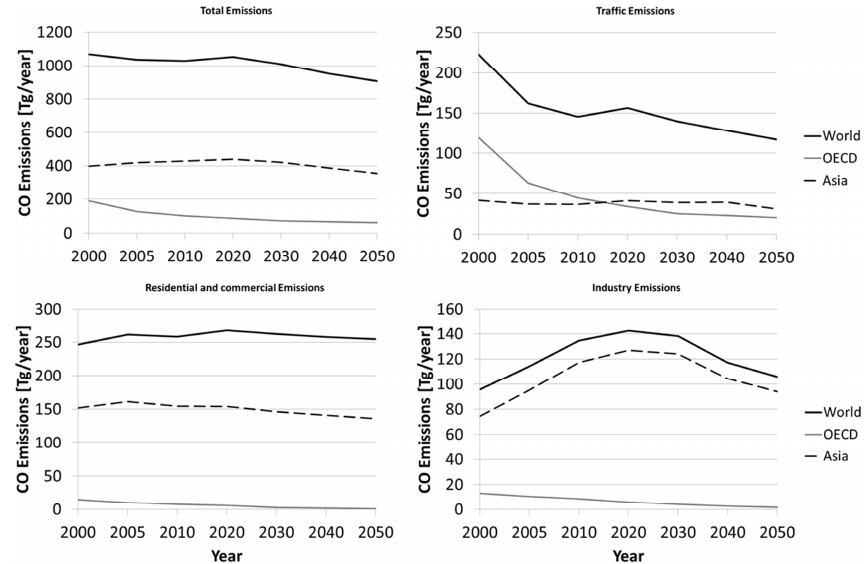
Figure 9. Annual CO anthropogenic emissions 2000–2050 from different sectors in the RCP8.5 scenario, worldwide, for OECD countries and for